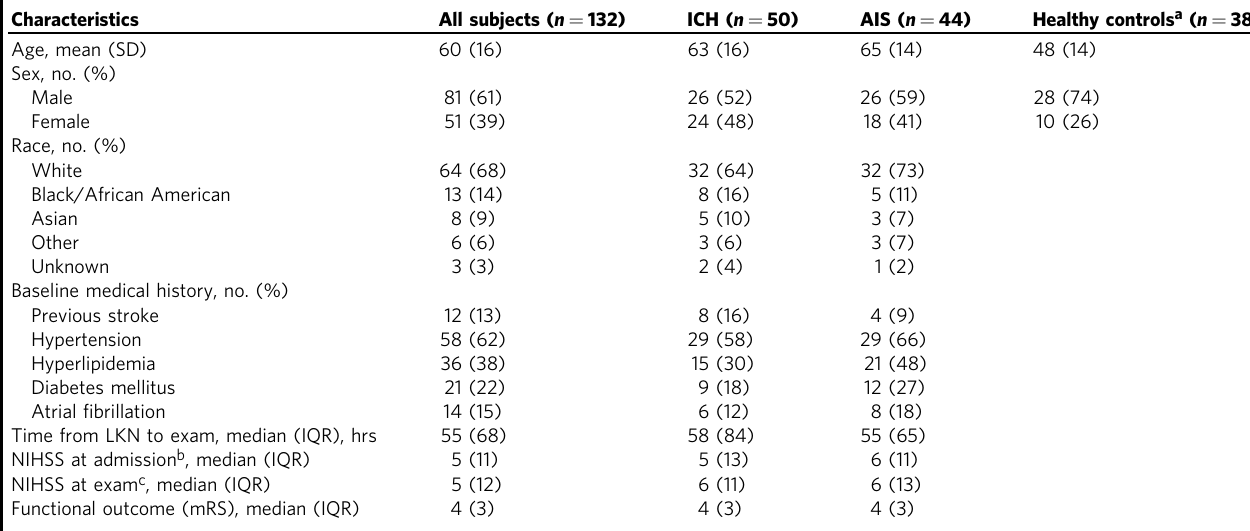
Examples of true positive neuroimaging fi ndings are shown in Fig. 2, compared to traditional high- fi eld MRI or CT. Figure 3 demonstrates false negative neuroimaging fi ndings for ICH.